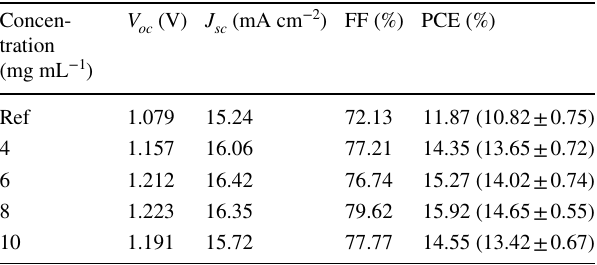
Table 1 The photovoltaic parameters and average efficiency of vari- ous FABr concentration treated devices Concen- tration (mg mL −1 )